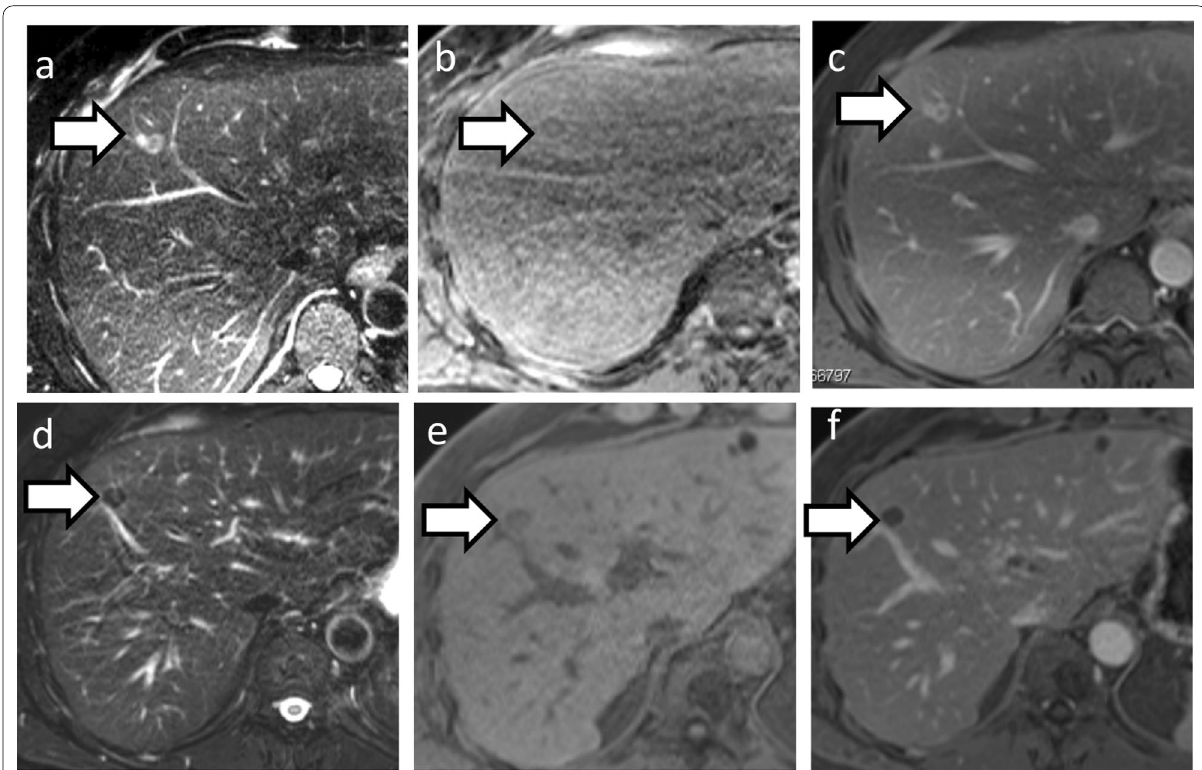
Fig. 4 Hepatic metastasis in segment IV in a 55‑year old patient suffering from rectal cancer with further pulmonary metastasis ( a T2w, b T1w, c T1w post contrast media application). After radiofrequency therapy of the liver, complete response was achieved without any disease recurrence 15 years later ( d T2w, e T1w, f T1w post contrast media